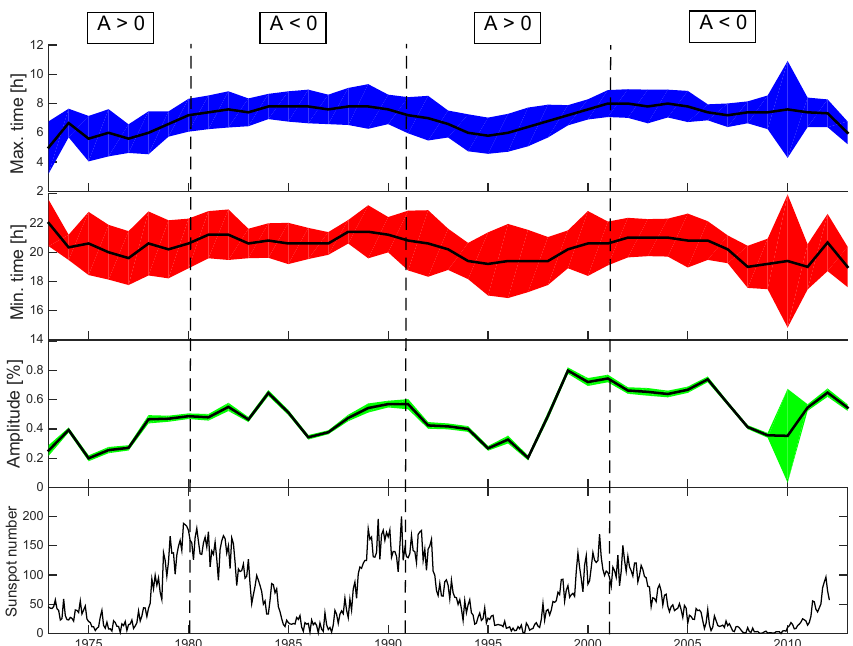
Figure 9. Neutron monitor data are from Alma-Ata, Kazakhstan (43.3 ◦ N, 76.9 ◦ E). Mean times of day of (from top) the maximum in the diurnal variation of neutron monitor counts, the minimum, the mean amplitudes of the variation and the international sunspot number. Shaded regions are the error calculated for individual years as the times. The computation of uncertainties is described in the text. The vertical dashed lines are times of polarity reversal estimate by Thomas et al. (2014a) and the solar magnetic polarity of each cycle is labelled at the top.